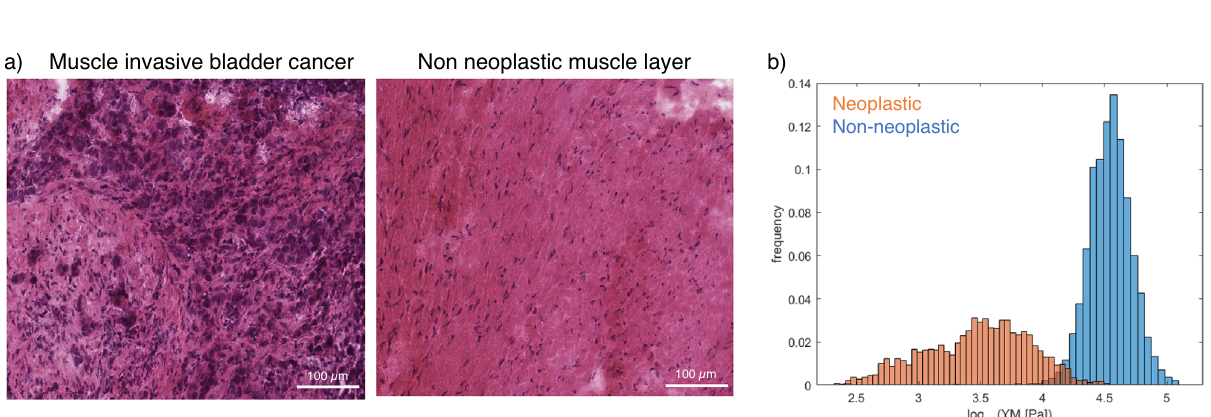
Fig. 4 Micromechanics of murine bladder in a model of bladder cancer (BBN). a ) Animal model establishment. Representative bladder wall stiffness gradients collected with nanoindenter at ( b ) 2 months of BBN treatment, where urothelium dysplasia is marked by *; ( c ) 4 months of BBN treatment, where pTa tumor limited to the urothelium without invading the lamina propria is marked by **. pT1 tumors in which urothelial tumor cells break the basal membrane and invade the lamina propria below at 4 and ( d ) 6 months BBN treatment are marked by ***. U: urothelium, L: lamina propria, M: muscle. YM ’ s from BBN treated bladders (black) at ( e ) 2 months, ( f ) 4 months and ( g ) 6 months of BBN treatment; and comparison to healthy animals of the same age (grey) measured both with nanoindenter and AFM. N = 3 rats per time point and condition, each tissue layer of each single rat is characterized by over 3000 force curve measurements. Data shown are logarithm in base 10 of YM ’ s (in Pa). h Fold of change of mean of the median log10 YM values of treated rats ± standard deviation (with propagated error) respect to control rats. T-test showed statistically signi fi cant softening with respect to the control animals (mean ± standard deviation with propagated error are shown. ns = not signi fi cant, * = p value < 0.05, ** = p value < 0.005, *** = p value < 0.0005). i Mean of the median values of each rat. 2-way Anova showed that statistically signi fi cant differences in the BBN model were observed in the urothelium from month 2 to month 4, and from month 4 to month 6; and for the lamina propria from month 4 to month 6. Source data behind graphs and charts can be found in